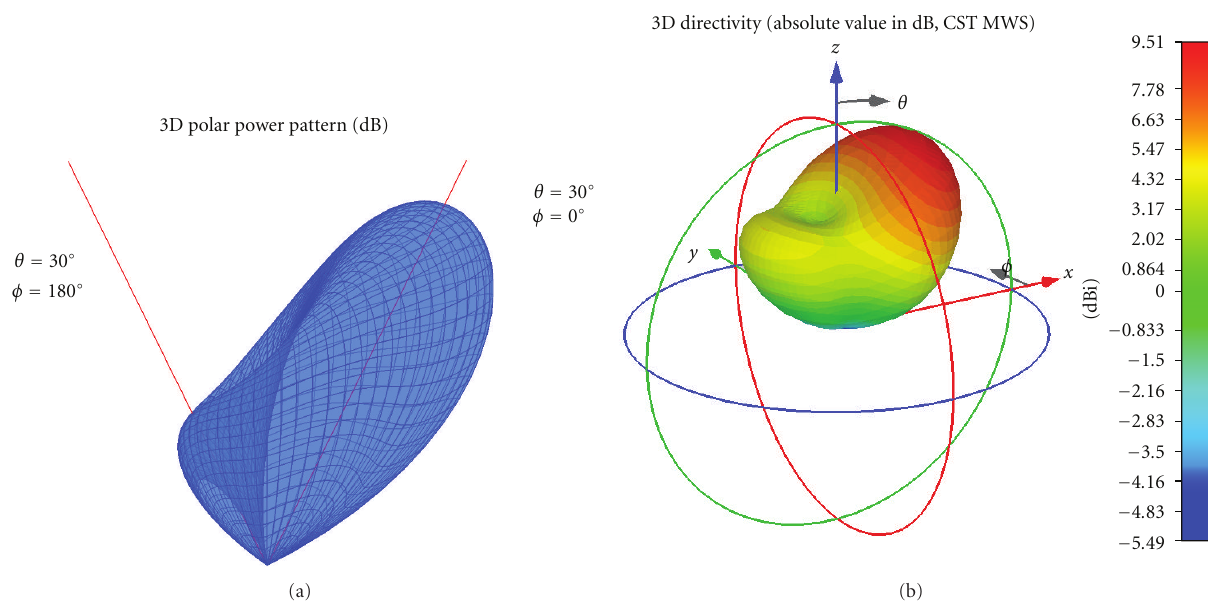
Figure 5: (a) 3D Polar normalized power pattern (values 20dB below maximum are not represented) and (b) 3D Directivity pattern by means of CST MWS (absolute value in dB), respectively, for an array with prescribed maximum at φ = 0 and θ = 30 ◦ and a attenuated value 7dB below the maximum at φ = 180 and θ = 30 ◦ . Loading reactances: jX 1 = 9 . 52 j Ω , jX 2 = − 42 . 55 j Ω , jX 3 = 84 . 39 j Ω , jX 4 = 242 . 69 j Ω , X = 66 . 39 j Ω , and X = − 45 . 83 j Ω . Both cases have been compared with the results obtained by CST Microwave Studio. 5 6